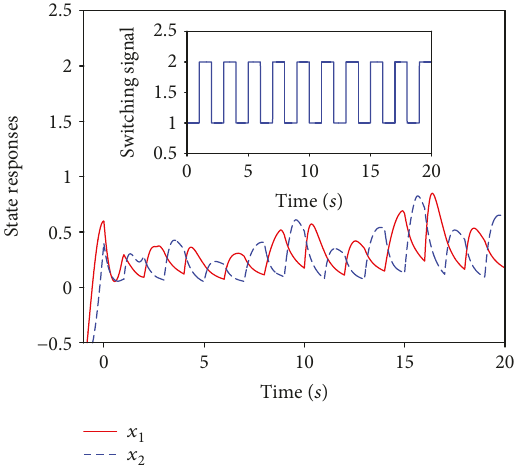
Figure 10: State responses of the considered SNNs for Example 2 with average dwell time T = 1 s < T ∗ . 1